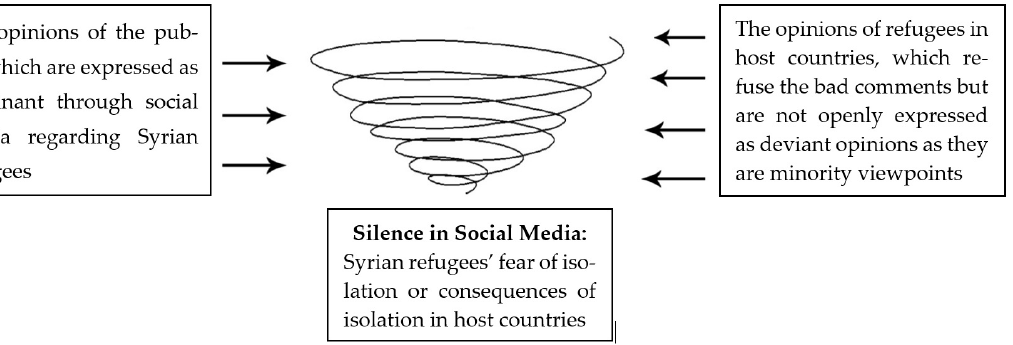
Figure 3. Spiral of silence among the participants on social media, stimulated from the main model of Noelle-Neumann (Source= Noelle-Neumann, 1993).